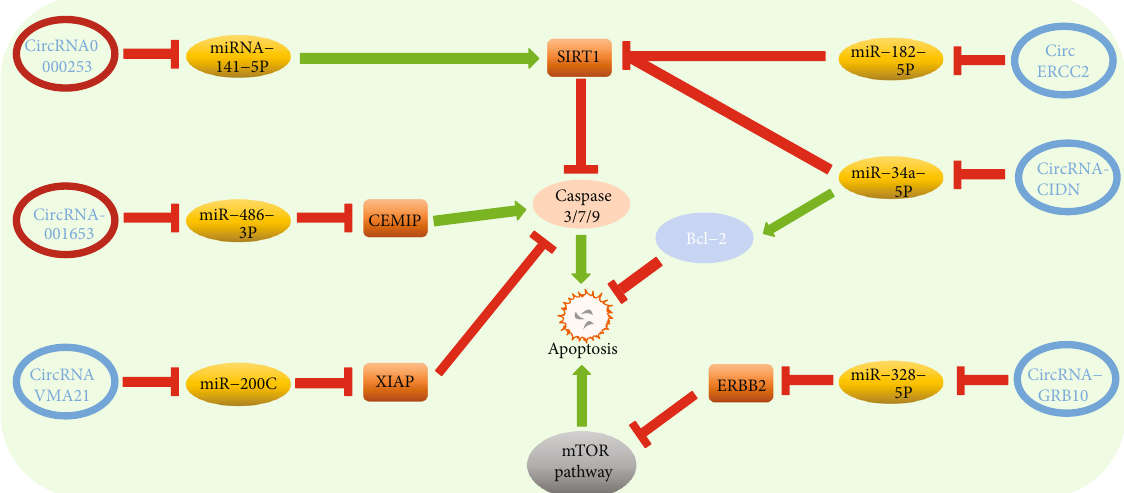
Figure 4: (a) CEMIP: cell migration-inducing hyaluronan-binding protein is closely related to cellular invasion, proliferation, and motility [88] (b) XIAP: XIAP belongs to the inhibitor-of-apoptosis proteins (IAP) that represent a family of endogenous caspase inhibitors and can bind and directly inhibit the activity of the three most important apoptosis e ff ector caspases: caspase-3, caspase-7, and caspase-9 [74]. (c) ERBB2: ERBB2 is tyrosine kinase receptor which inhibits autophagy via the formation of a complex with Beclin 1, which is a key regulator of autophagy [82]. (d) SIRT1 is a NAD + -dependent deacetylase that can reduce apoptosis in several di ff erent cells [73]. (e) Bcl- 2 belongs to the antiapoptotic protein [91]. Table 1: The role of circRNAs in intervertebral disc degeneration.